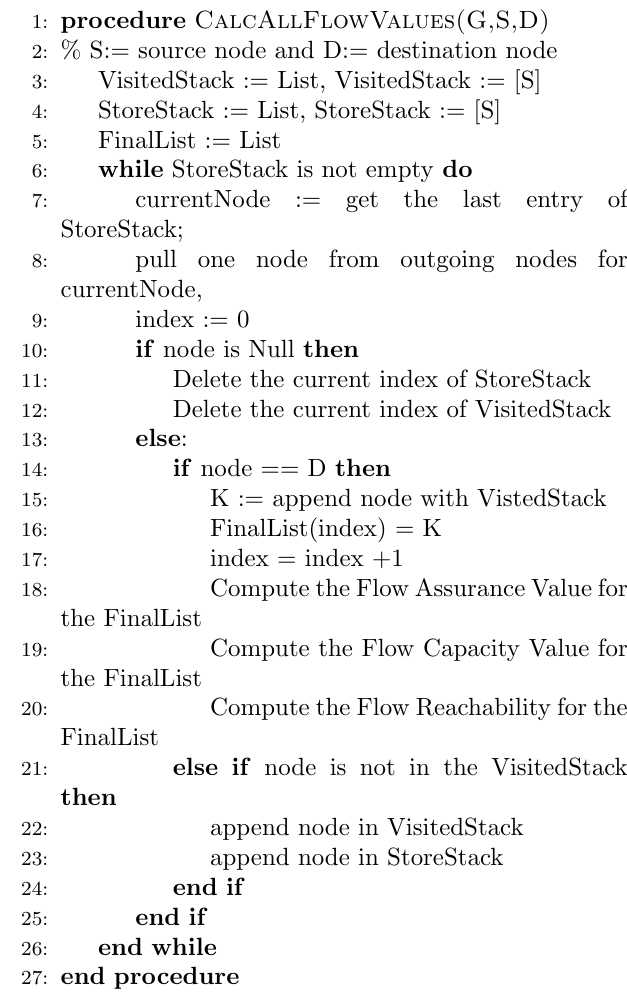
Algorithm 1 Calculation of λ, ζ, η all Flow